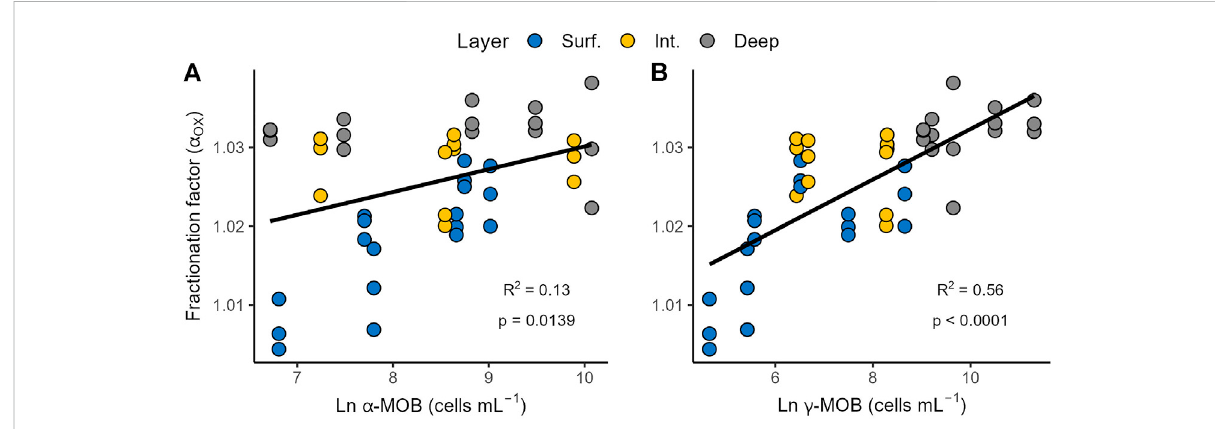
FIGURE 5 Relationships between carbon stable isotopic fractionation factor ( α ox ) and the abundance of α -MOB (A) and γ -MOB (B) in the study